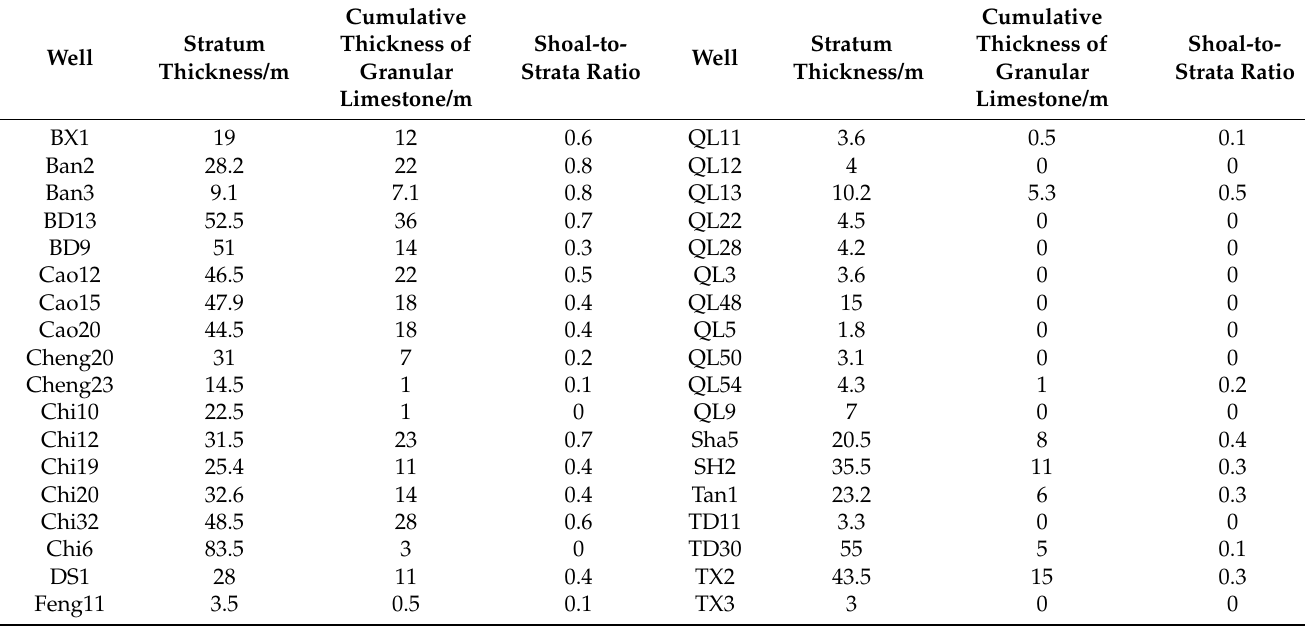
Table 1. Statistical data of the shoal-to-strata ratio in the P 2 m 2 a, Eastern